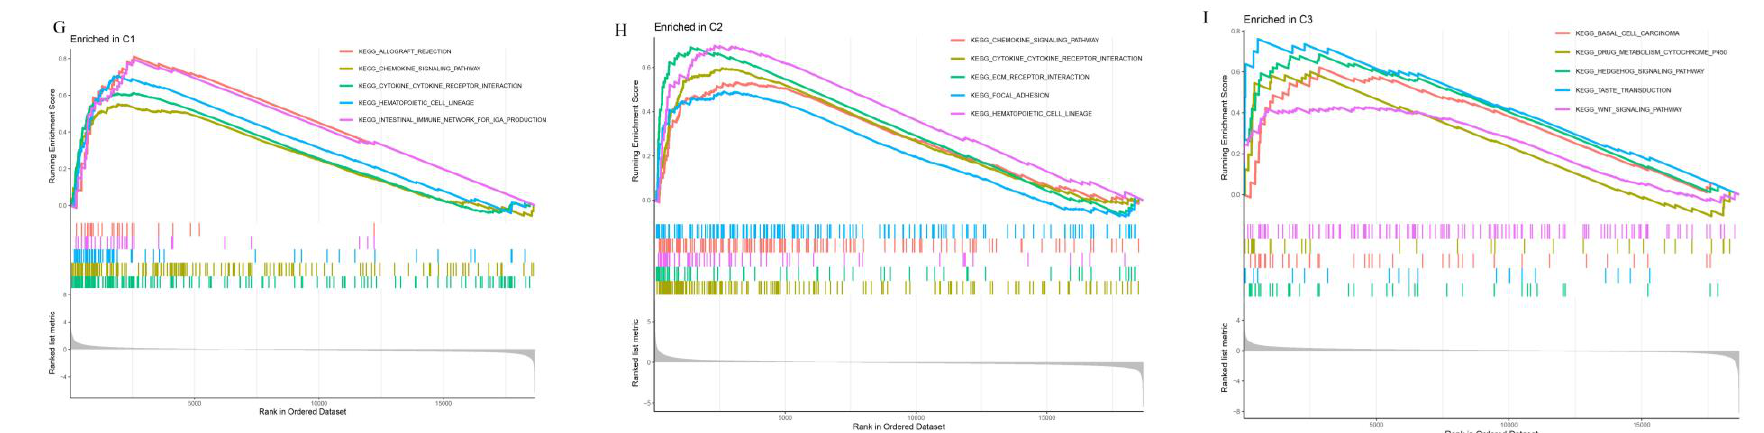
Figure 9. Assessment of prognosis-related protein function, tumor-infiltrating immune cells, and immune checkpoints. ( A ) GSEA analysis of the five pathways in the high-risk score group. ( B ) GSEA analysis of the five pathways in the low-risk score group. ( C ) Tumor-infiltrating immune cell analysis between the high-risk and low-risk groups. ( D ) Tumor-infiltrating immune cell analysis across prognostic-related protein subgroups. ( E ) Immune checkpoint analysis between the high-risk and low-risk groups. ( F ) Immune checkpoint analysis across prognostic-related protein subgroups. ( G ) GSEA analysis of the five pathways in C1. ( H ) GSEA analysis of the five pathways in C2. ( I ) GSEA analysis of the five pathways in C3 (* p < 0.05, ** p < 0.01, *** p < 0.001).